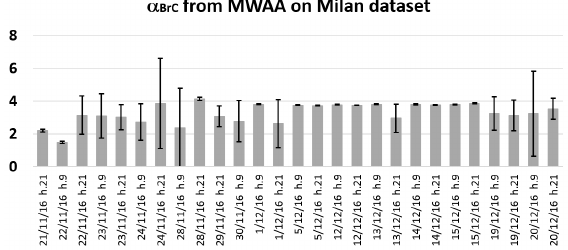
Figure 6. 5- λ b abs and α exp determined on the Milan dataset. Date and time referring to the beginning